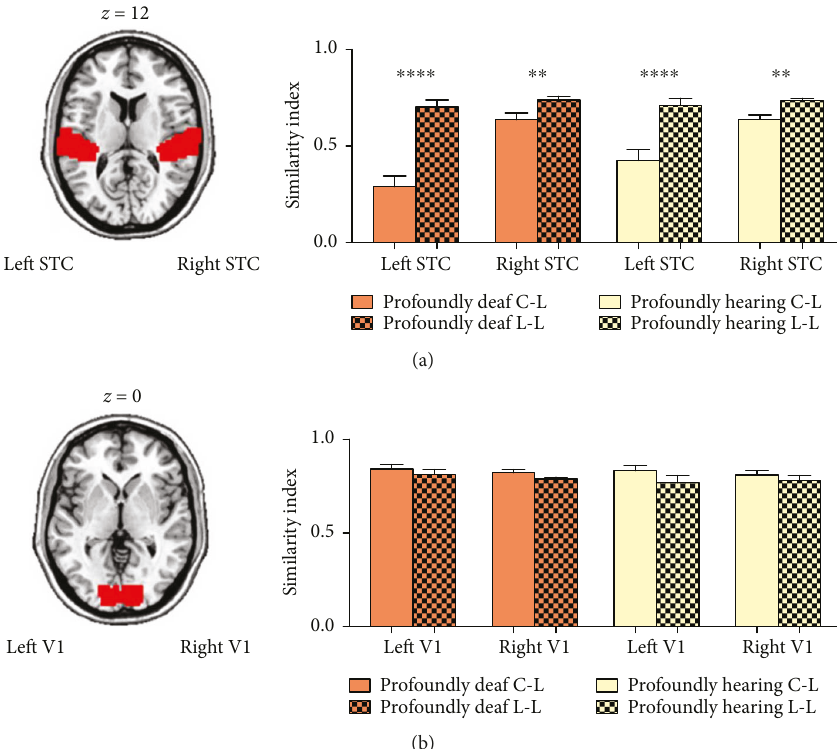
Figure 6: Representational similarities in activation patterns in the superior temporal cortex (STC) and primary visual cortex. (a) Axial slice depicting the auditory region of interest (ROI; Brodmann areas (BAs) 41 and 42) in red. The bars indicate the similarity (correlation coe ffi cient index) of the spatial activation patterns between visual stimuli within the ROI. The solid bars depict the averaged similarities between checkerboard and language-related stimuli (C-L), including sign language, words, and lip-reading, in both the profoundly deaf group (in orange) and the residual hearing group (in yellow). The grid bars depict the average correlation coe ffi cients between language- related stimuli (L-L). The correlation coe ffi cient between language-related stimuli in the bilateral auditory ROIs was signi fi cantly higher than that between checkerboard and language-related stimuli in both the profoundly deaf group (left hemisphere: p < 0 0001 , right hemisphere: p < 0 001 ) and the residual hearing group (left hemisphere: p < 0 0001 , right hemisphere: p < 0 0016 ). (b) Such di ff erences in representational similarity were not observed in the primary visual cortex (V1; BA17). ∗∗ p < 0 01 ; ∗∗∗∗ p < 0 0001 . Error bars represent 1 standard